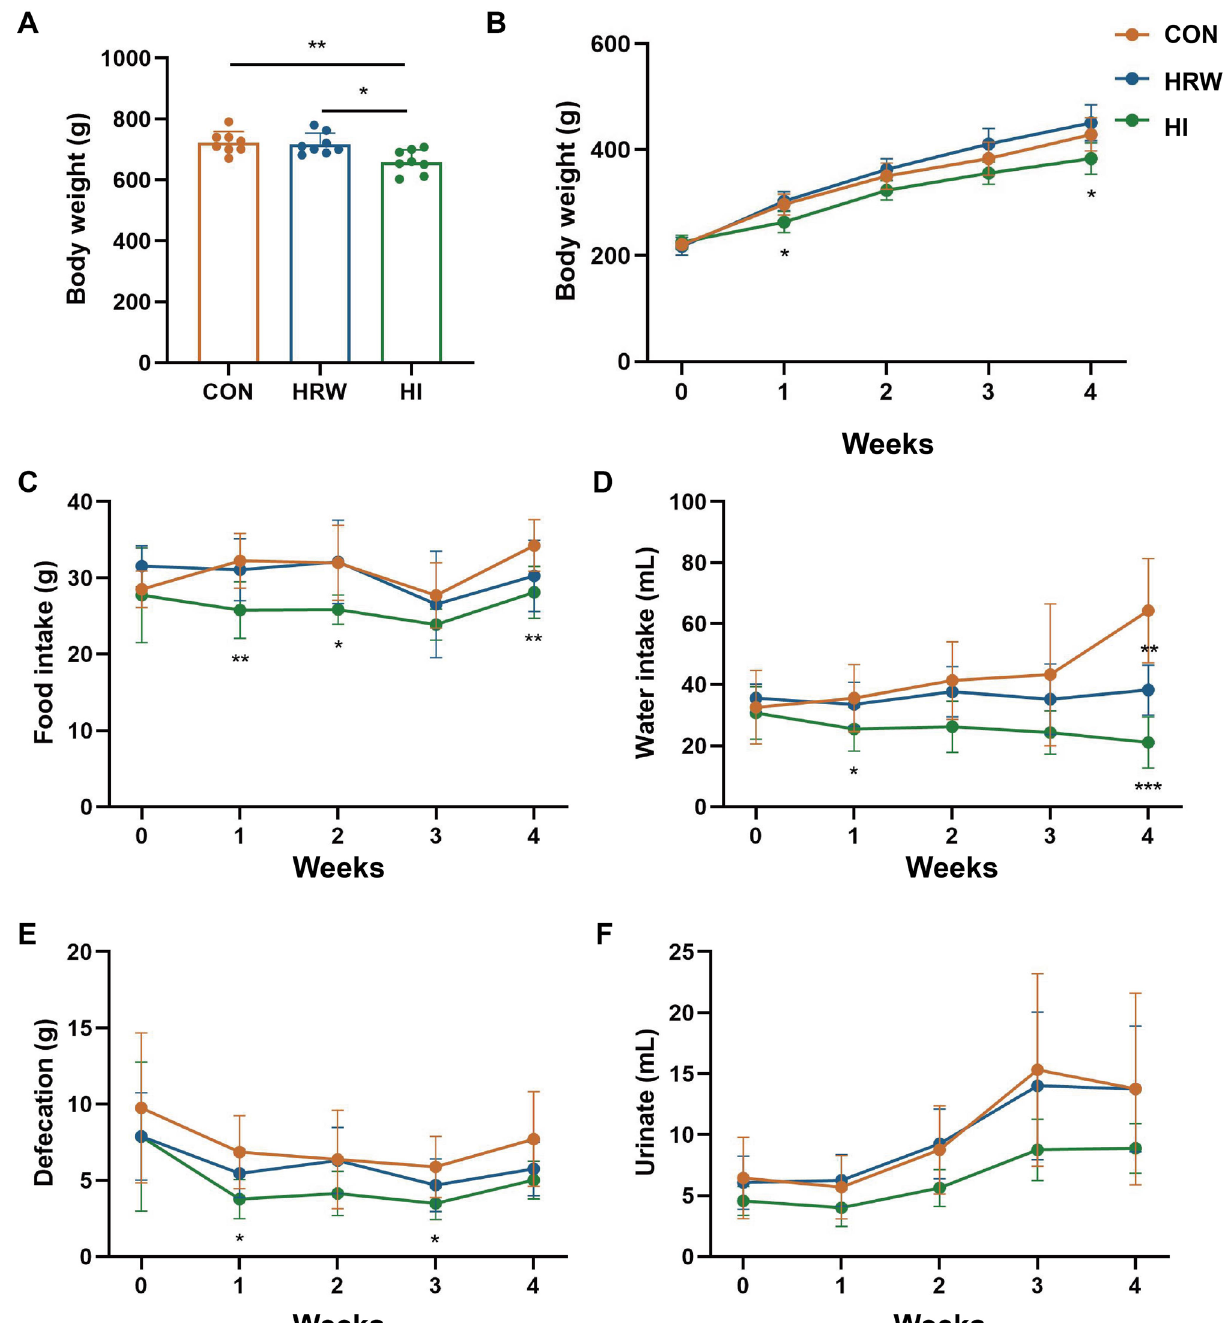
Figure 1. The effects of hydrogen intervention on the BW and metabolic function of rats. ( A ) BW changes at six month after hydrogen treatment; ( B ) BW changes during the first month after hydrogen treatment; ( C – F ) the effects of hydrogen treatment on food intake ( C ), water intake ( D ), defecation ( E ), and urinate ( F [Chao1 (Fig. 4A), PD whole tree (Fig. 4B), Shannon (Fig. 4C), and Simpson (Fig. 4D)] all fail to report significant difference between the control group and HRW or HI group. However, the PD whole tree index was signifi- cantly higher in HI group than that in HRW group (Fig. 4B). Analysis of similarities (ANOSIM) was performed to quantitatively compare the bacterial community differences between different groups. As shown in Fig. 4E, ANOSIM revealed significant difference in the structure of gut microbiota between HRW and the control group (ANOSIM, r = 0.304, p = 0.005). Significant bacterial community differences was also observed between HRW and HI group (Fig. 4G, ANOSIM, r = 0.369, p = 0.003). However, no significant difference was observed between HI and the control group (Fig. 4F, ANOSIM, r = − 0.065, p = 0.65). The Wilcoxon rank-sum test was performed to identify differences in relative abundances of bacteria between the two groups. At the phyla levels, as shown in Fig. 4H, the dominant phyla of the three groups were Firmicutes , Bacteroidetes , Proteobacteria , and Actinobac-